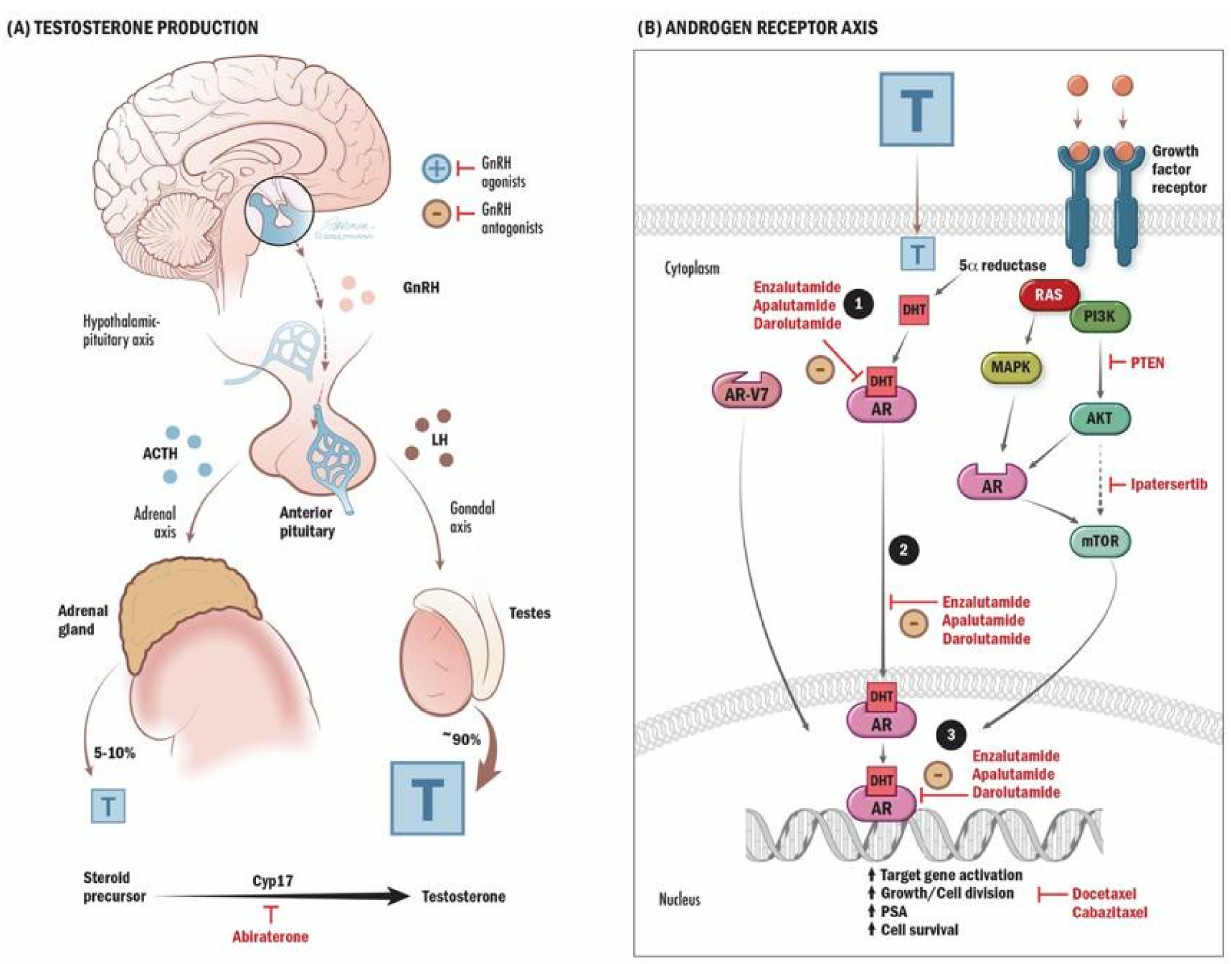
Figure 1. Androgen Synthesis and Mechanism of Action. ( A ) Gonadotropin-releasing hormone (GnRH) is typically released from the hypothalamus in a pulsatile fashion to signal the anterior pituitary to release follicle-stimulating hormone (FSH) and luteinizing hormone (LH), which then signal the gonads to produce testosterone through the hypothalamic–pituitary–gonadal (HPG) axis and is responsible for 90% of the body’s testosterone production (represented by T in the figure). GnRH also signals the pituitary to release adrenocorticotropin-releasing hormone (ACTH) to signal the adrenal glands to produce androgens. Chemical androgen deprivation therapy (ADT) consists of GnRH agonists or antagonists, which inhibit these pathways. The production of testosterone itself involves the conversion of steroid precursor molecules into testosterone in part by the enzyme cyp17. Abiraterone is an androgen receptor-axis targeted agent (ARAT) that works by inhibiting this enzyme and, ultimately, androgen production. ( B ) Testosterone, as steroid molecules, typically then diffuses through the cell membrane into the prostate cancer cell, where they are converted by 5-alpha-reductase into dihydrotestosterone (DHT), which then binds to the intracellular androgen receptor (AR). This receptor complex then migrates into the nucleus and is involved in transcription and translation of genes involved in cell growth and division. Chemotherapy such as docetaxel and cabazitaxel exert their effects by interfering with the cell cycle, growth, and division.